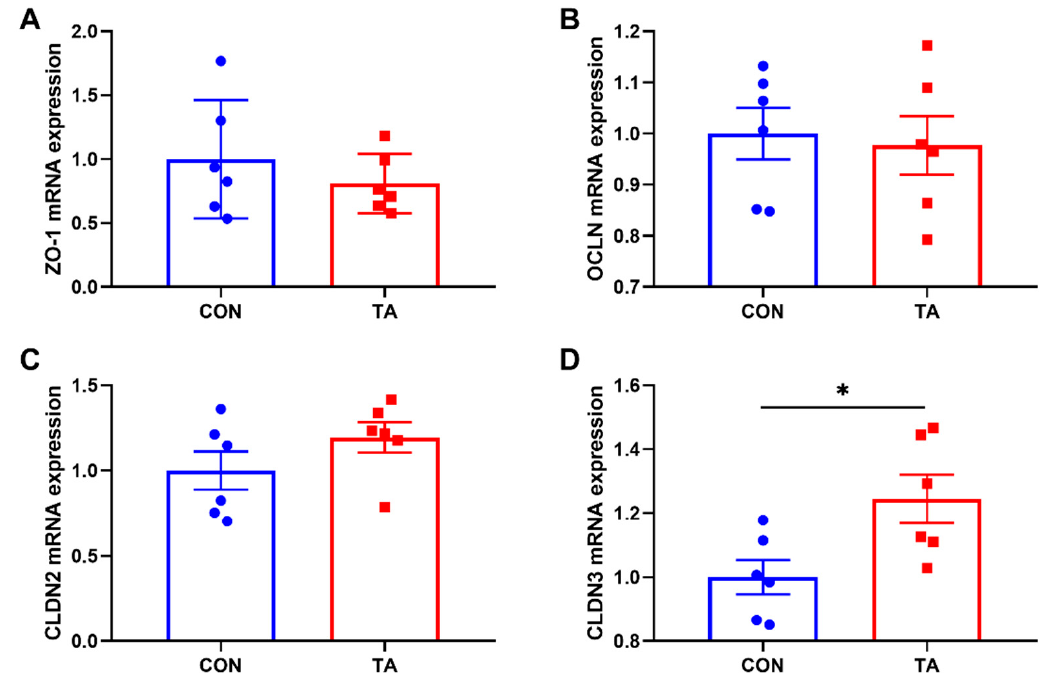
Figure 5. Effects of tannic acid extracted from Galla chinensis supplementation on expressions of tight junction proteins in intestinal mucosa of broiler chickens. ( A ) Zonula occludens-1 (ZO-1); ( B ) Occludin (OCLN); ( C ) Claudin 2 (CLDN2); ( D ) Claudin 3 (CLDN3). CON, broiler chickens fed basal diet; TA, broiler chickens fed basal diet supplemented with 300 mg/kg microencapsulated tannic acid extracted from Galla chinensis . Values are mean ± standard error ( n = 6). Differences between treatments were displayed by * p <